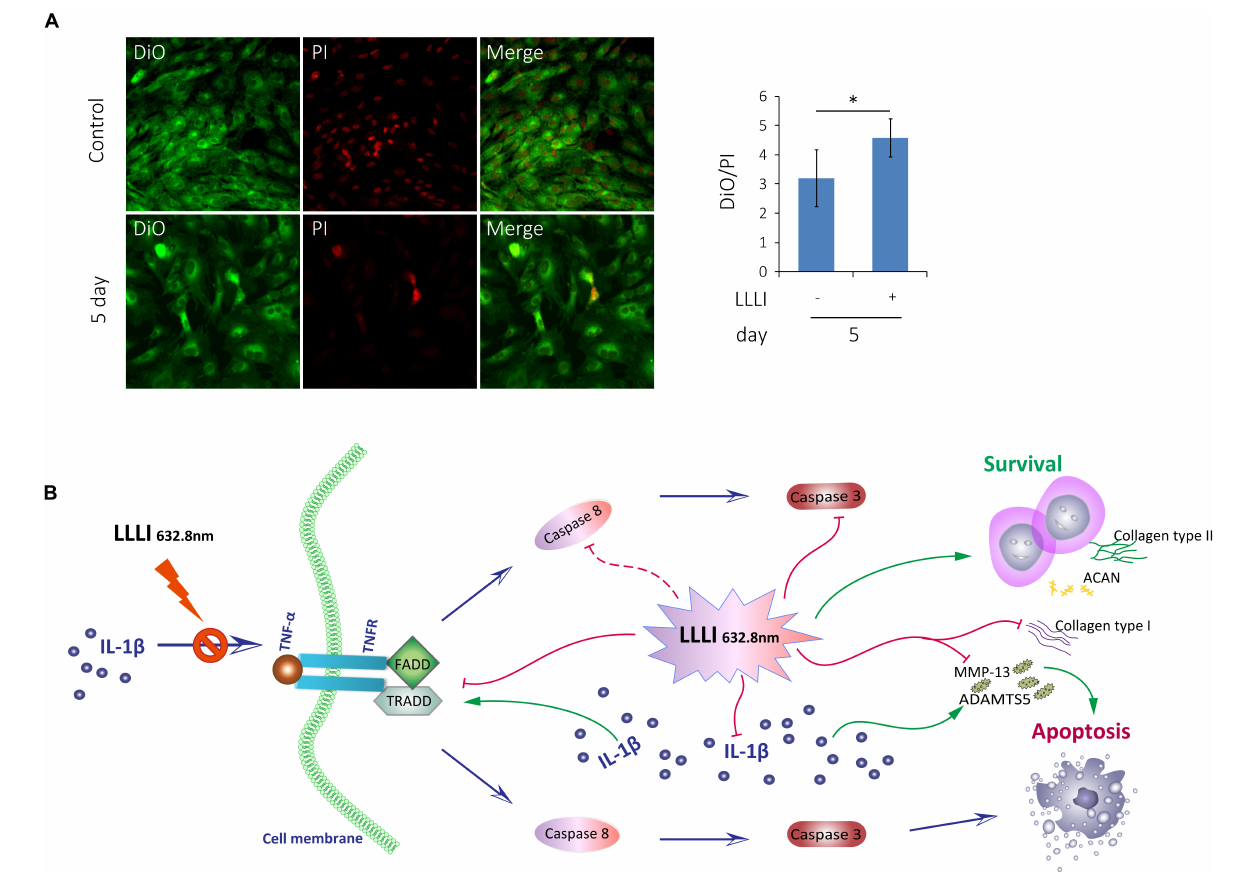
FIGURE 7 | Inhibition of LLLI on apoptosis of cultured rabbit chondrocytes by modulation of the extrinsic apoptosis pathway. (A) Chondrocytes in culture were treated with LLLI of 5.74 J/cm 2 daily in culture for 5 days and labeled by DiO/PI for live/dead cells, which show live cells as green and the dead cells as red fluorescence under CLSM. Both treated and untreated groups showed live cells (green) and dead cells (red) and merged images of the population (left panel). The intensity of fluorescent color was acquired by CLSM using dual channels and the green/red ratio of treated cells was quantitatively compared to that of control cells, showing significantly ( ∗ ) more live cells than control (right panel). (B) Schematic illustration of LLLI-inhibited expression of collagenases ADAMTS5 and MMP-13 , and the fibroblastic Cal1 α 1 ; the IL-1 β -induced cytokine TNF- α and its receptor TNFR1 , the association of which triggers the recruitment of the death domain (DD) together with TNF receptor-associated death domain ( TRADD ), Fas-associated death domain ( FADD ) proteins to form the death inducing signaling complex (DISC). The DISC activates the initiating caspases, including the known initiator caspase-8 (unexamined in this study and indicated by a dotted line), which, in turn, activates executioner caspases, such as caspase-3, to destroy cellular substrates causing cell apoptosis. Scaled bar (—) represents 100 µ m. Daily LLLI treatment = 5.74 J/cm 2 of LLLI for 8 min; Error bar = SD; ∗ P <